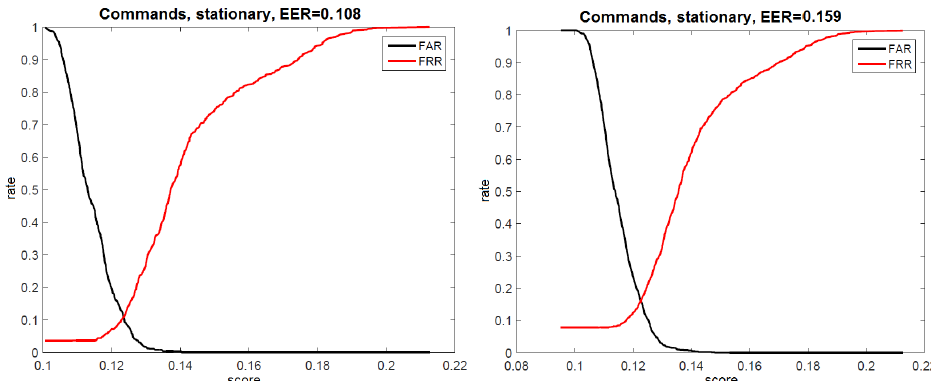
Figure 29. FAR–FRR (False Acceptance Rate–False Rejection Rate) diagram of off-line (Left Drawing) and on-line (Right Drawing) command recognition (20 commands) with stationary microphones.